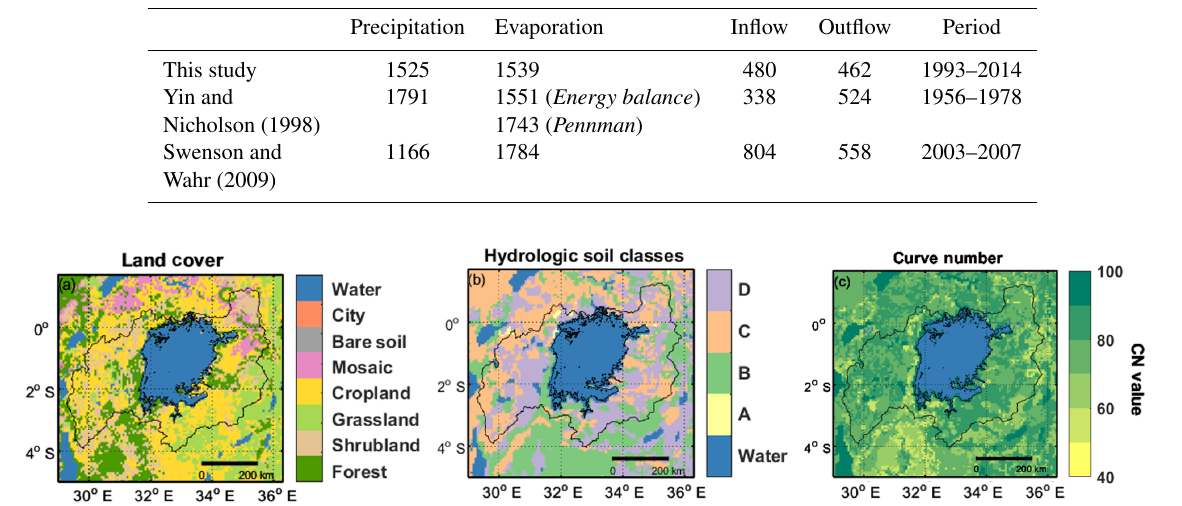
Figure 6. Land cover (a) , Hydrologic Soil Groups (b) and curve number (c) .